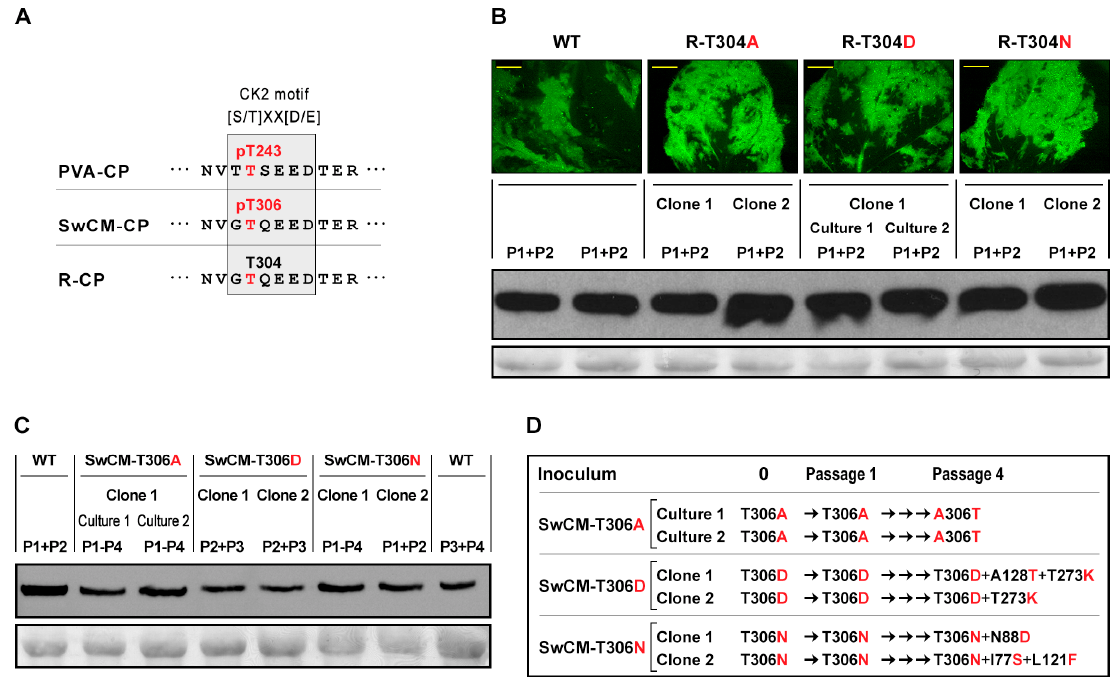
Figure 5. Effect of preventing or emulating phosphorylation at casein kinase 2 (CK2) motif of the coat protein (CP) of Plum pox virus (PPV). ( A ) CK2 motif in the CP of Potato virus A (PVA-CP), PPV-SwCM (SwCM-CP), and PPV-R (R-CP). The main phosphorylatable residue of PVA-CP (pT243), according to Lõhmus et al. (2017), and the corresponding ones of PPV CP are shown in red. ( B ) Images showing GFP-fluorescence taken under an epifluorescence microscope and CP-specific Western blot analysis of systemically infected leaves of Nicotiana benthamiana plants inoculated by hand-rubbing with DNA of pICPPV-NK-lGFP (WT) or the indicated pICPPV-NK-lGFP-derived plasmids, collected at 21 days post-inoculation (dpi). Bars, 5 mm. ( C ) CP-specific Western blot analysis of systemically infected leaves of Nicotiana benthamiana plants inoculated by hand-rubbing with DNA of pICPPV-CPSwCM-R (WT) or the indicated pICPPV-CPSwCM-R-derived plasmids, collected at 21 dpi. For both ( B ) and ( C ), inoculations were done with two different clones per construct or, in the case of R-T304D and SwCM-T306A, with two different DNA preparations of a single clone. Pooled plants (P1 to P4) are indicated. Blots stained with Ponceau red showing the ribulose-1,5-bisphosphate carboxylase/oxygenase (RuBisCO) large subunit are included as loading controls. ( D ) Serial passages through N. benthamiana plants of viral progenies of PPV-CPSwCM-R-derived mutants. Two lineages were followed for each mutant virus progeny, which were initiated with pools of the two plants inoculated with each DNA sample. Passages were done by hand-rubbing inoculation of two plants using a crude extract of a pool of systemically infected leaves of the two plants inoculated in the former passage, collected at 21 dpi. Taken together, these results showed that CP phosphorylation was widespread among PPV strains and a ff ected protein sites in either ubiquitous or specific